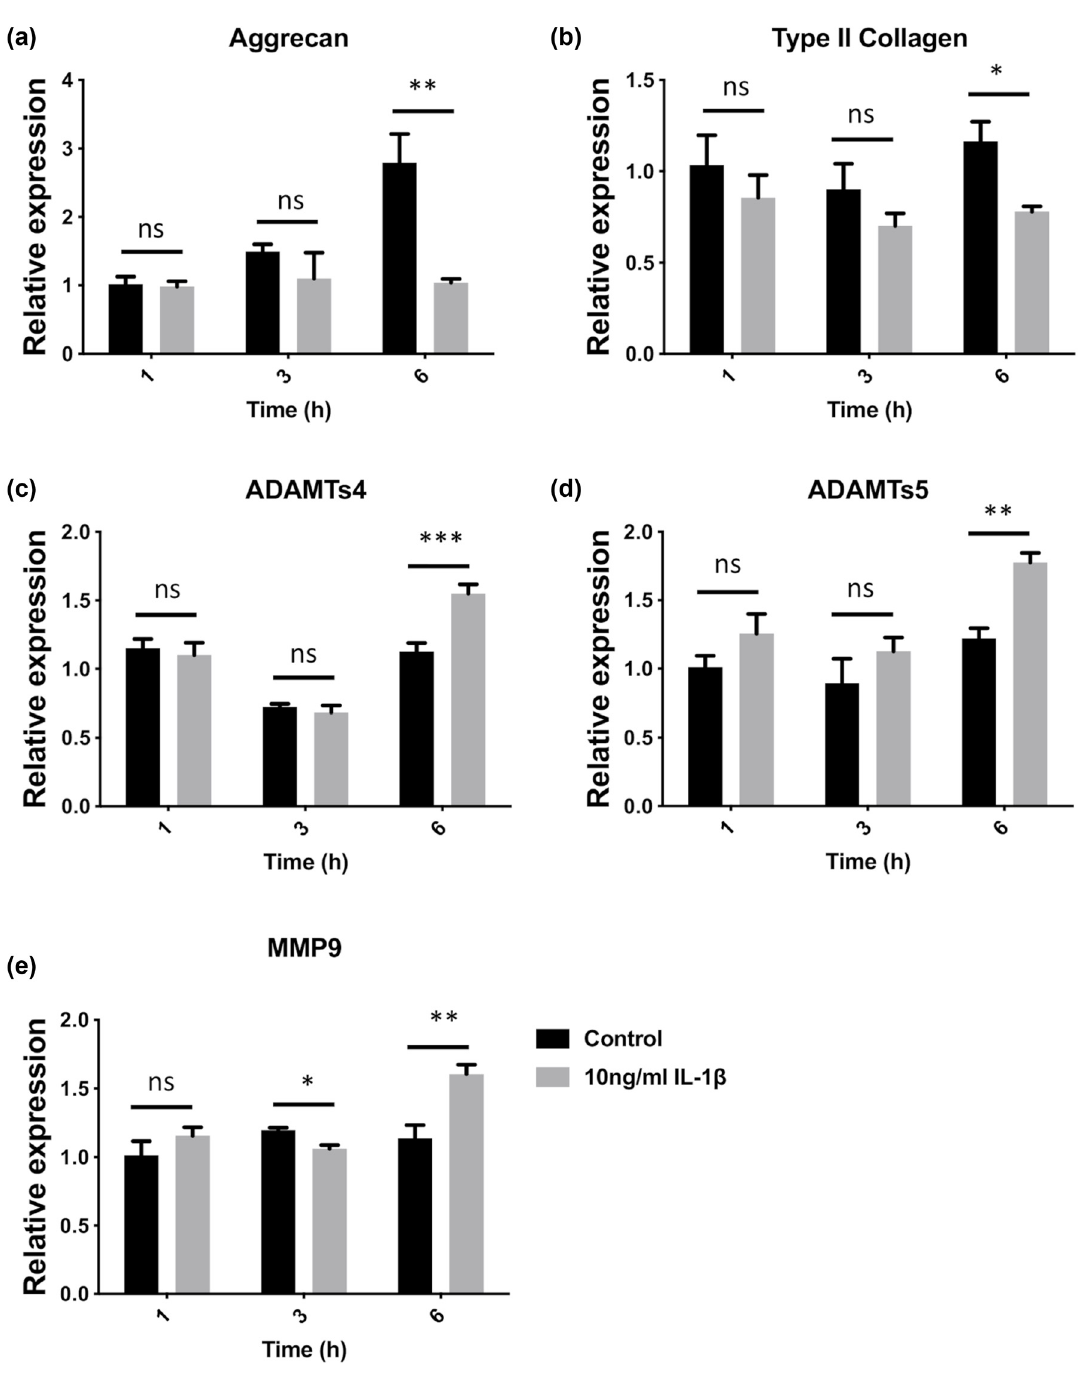
Figure 1: Expression levels of ECM - related genes in IL - 1 β - treated rabbit IMCCs. Expression levels of ( a ) aggrecan, ( b ) type II collagen, ( c ) ADAMTS - 4, ( d ) ADAMTS - 5, and ( e ) MMP - 9 were analyzed by qRT - PCR. All data are presented as mean ± SEM. * p < 0.05, ** p < 0.01, ns: not signi fi